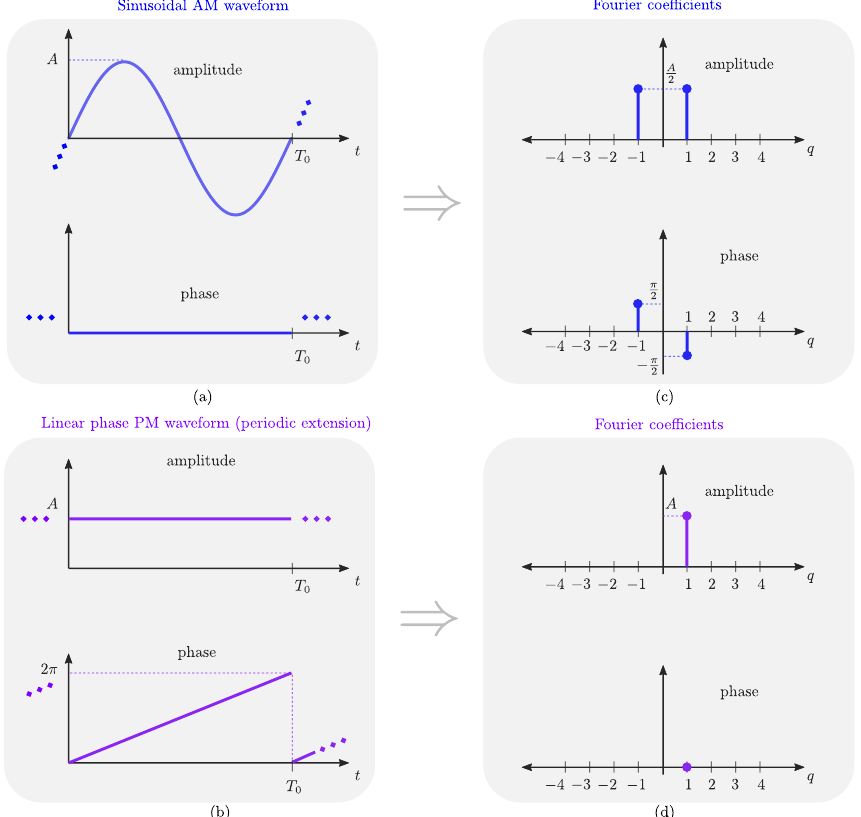
Figure 1. Representation of amplitude and phase versus time. ( a ) A sinusoidal AM waveform with period T 0 . ( b ) The periodic extension of a linear-phase PM waveform. ( c , d ) The Fourier coefficients versus q of the corresponding signals in ( a , b ), respectively (notice that the q -th coefficient accounts for the spectral component at the frequency q 2 π / T 0